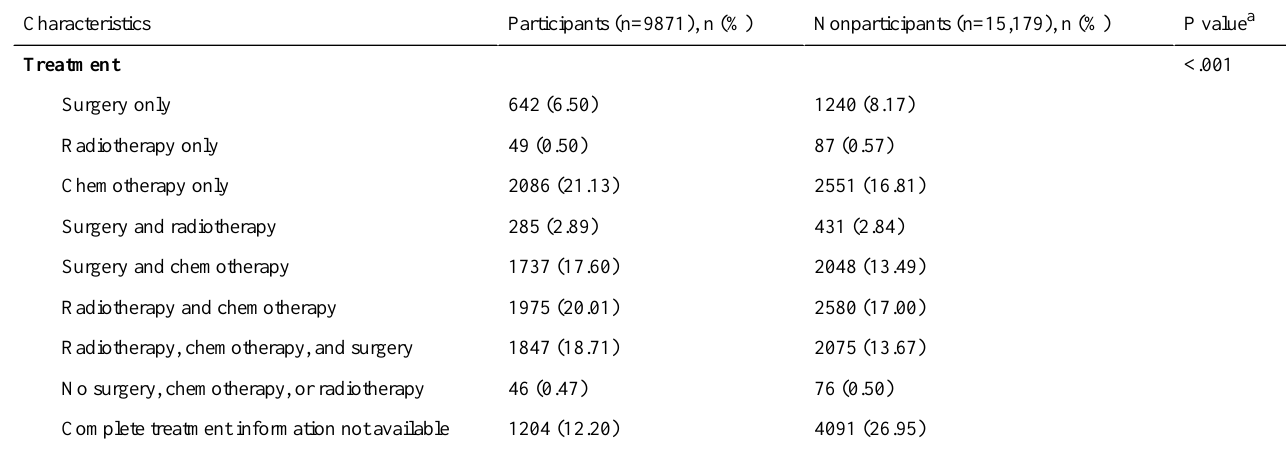
ICCC-3 main group XII (other and unspecified malignant neoplasms) and Langerhans cell histiocytosis but not benign and in situ tumors and tumor-like lesions or unclassified